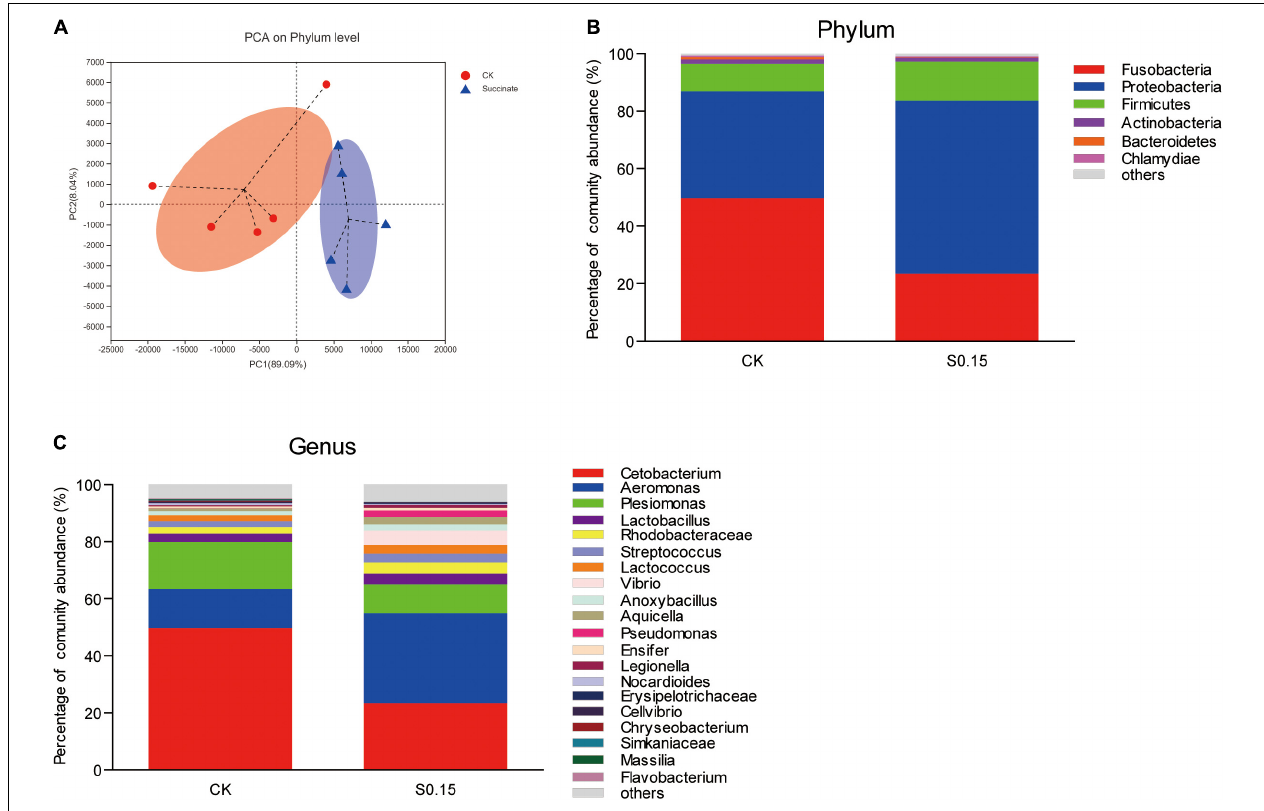
FIGURE 11 | Gut microbial community in zebrafish fed the CK or S0.15 diet for 4 weeks. (A) PCA analysis of the gut microbiota. (B) Relative abundance at the phylum level of the gut microbial community. (C) Relative abundance at the genus level of the gut microbial community. Values are means ± SEMs ( n = 5 biological replicates). CK, control-check diet; S0.15, 0.15% succinate-supplemented